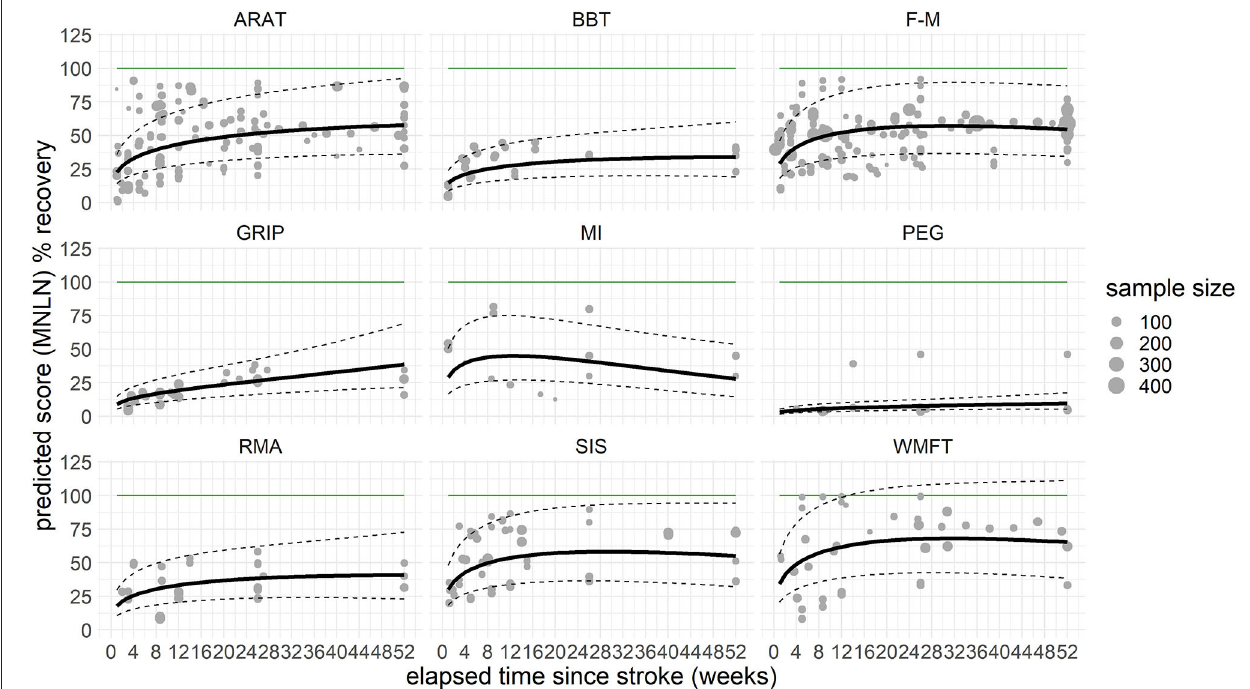
FIGURE 2 | Last observation carried forward (LOCF) prediction of recovery per assessment over the time course of 1 year, cross-fading the underlying raw values. The solid black line represents the predicted recovery pattern, based on log-transformed difference in means (MNLN) within the confidence interval of the prediction (dashed lines). The green horizontal line resembles a healthy score, respective to 100% recovery. The gray dots represent the underlying data points, with the size depicting the sample size of the respective data point. How these underlying data points are related is presented in Supplementary Figure 1 . ARAT, Action Research Arm Test; BBT, Box and Block test; F-M, Fugl–Meyer Assessment (upper extremity); GRIP, grip force; MI, Motricity Index; PEG, peg test; RMA, Rivermead Motor Assessment; SIS, Stroke Impact Scale; WMFT, Wolf Motor Function Test.